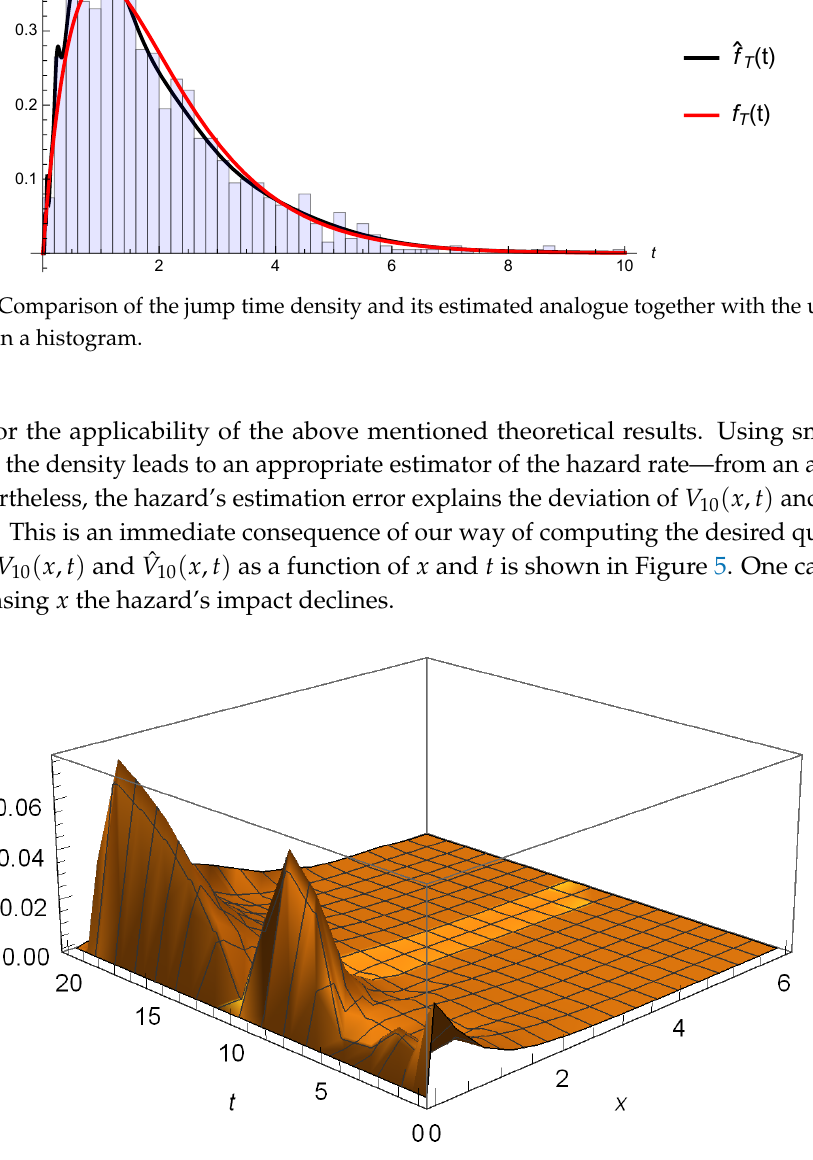
Figure 5. Difference of V 10 ( x , t ) and ˆ V 10 ( x , t )